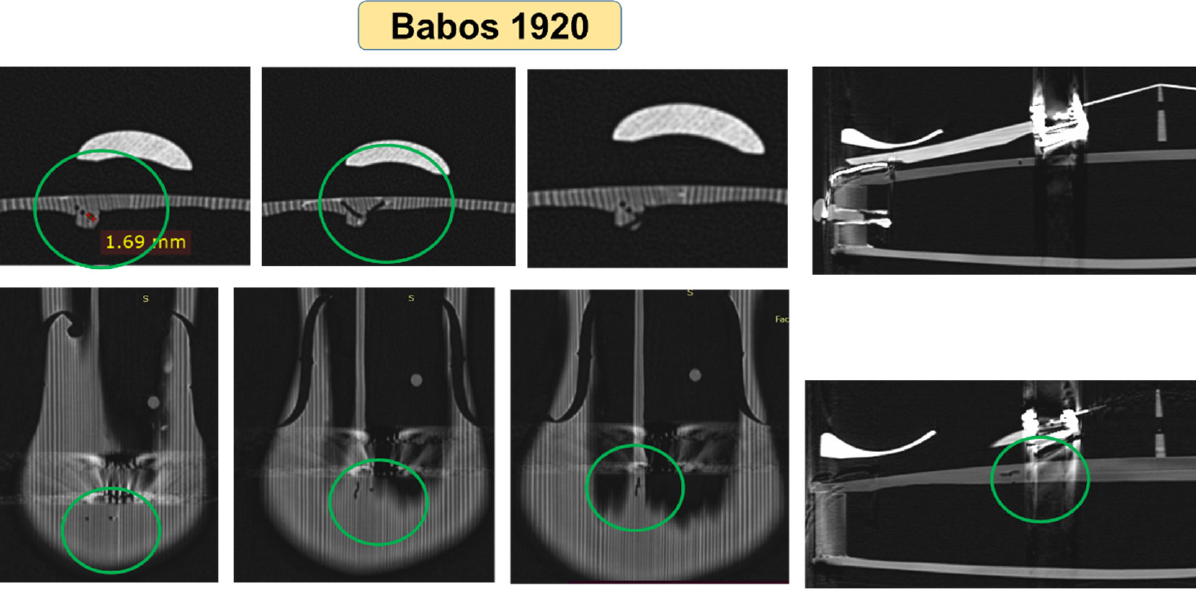
Figure 13. The trajectory of voids produced by coleoptera in case of the violin “Stainer, 1716”.